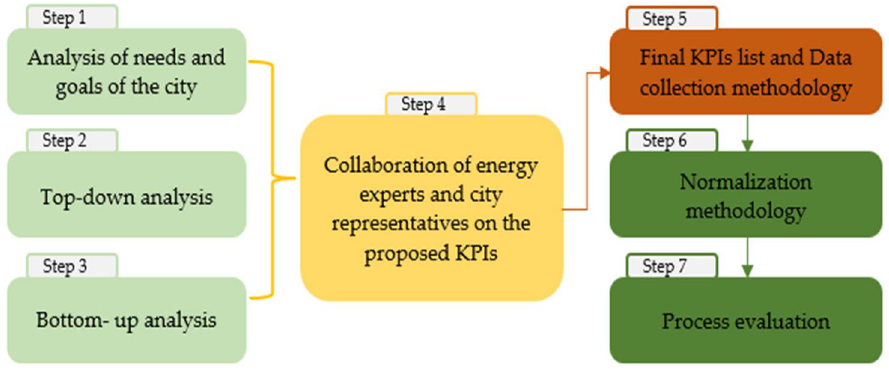
Figure 1. Seven-step impact assessment framework